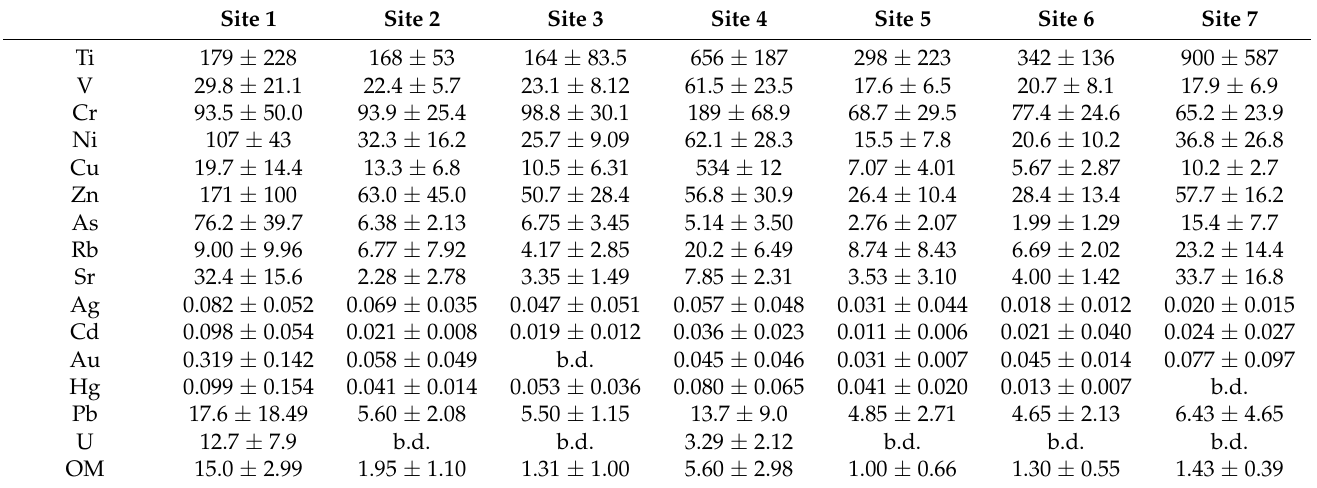
Table 3. Content of trace elements (mg/kg dw) and organic matter content (OM in %) in surface sediment samples from all sampling sites, b.d.: below the limit of detection (LOD), sampling size for each site: n =